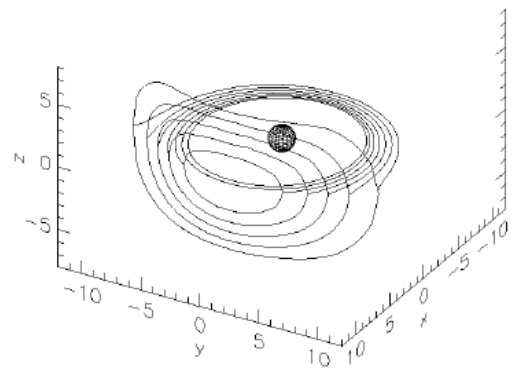
Figure 15. The configuration of B = const isolines, calculated us- ing the TS05 Tsyganenko and Sitnov (2005) model with quiet-time parameters (Fig. 1 from Antonova et al.,